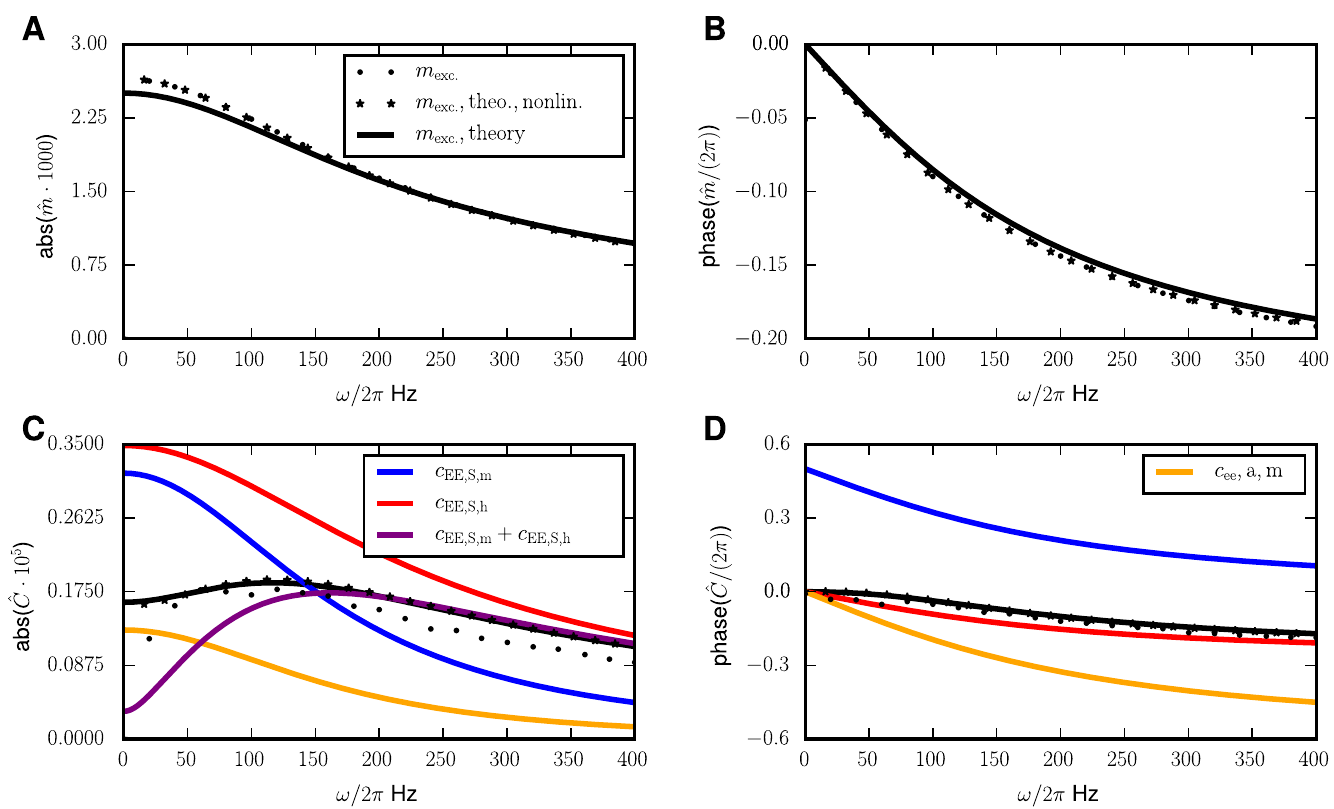
Fig 4. Periodically driven E-I network. A Amplitude of modulation of the mean activity deviatingfrom the stationary value for the excitatory population. B Phase of the modulation of the mean activity. C Different contributionsto the amplitudeof the covariancebetweenpairs of excitatory cells in dependence of the frequency ω of the externaldrive. D Phase of covariances relativeto the driving signal.Analytical theory (Eqs (9) and (39)) shown by solid black curves, numerical solutionsof the full mean field equations(Eqs (5) and (6)) (stars) and simulationresults (dots, only indicatedin the legendof A). Same color code as in C . In C and D , the contributionsto the variationof covariances are shown separately: The S h -term in red, the S m -term in blue, their sum in purpleand the a -term in yellow. The legendfor C and D is split over both panels. Numericalsolutionsobtained by the same methods as in Fig 3. Parameters: N E = N I = N X = 8192, p E = p I = p X = p = 0.2, m E = m I (cid:25) 0.11, m X = 0.25, identicalto [13, e.g. fig. 6].